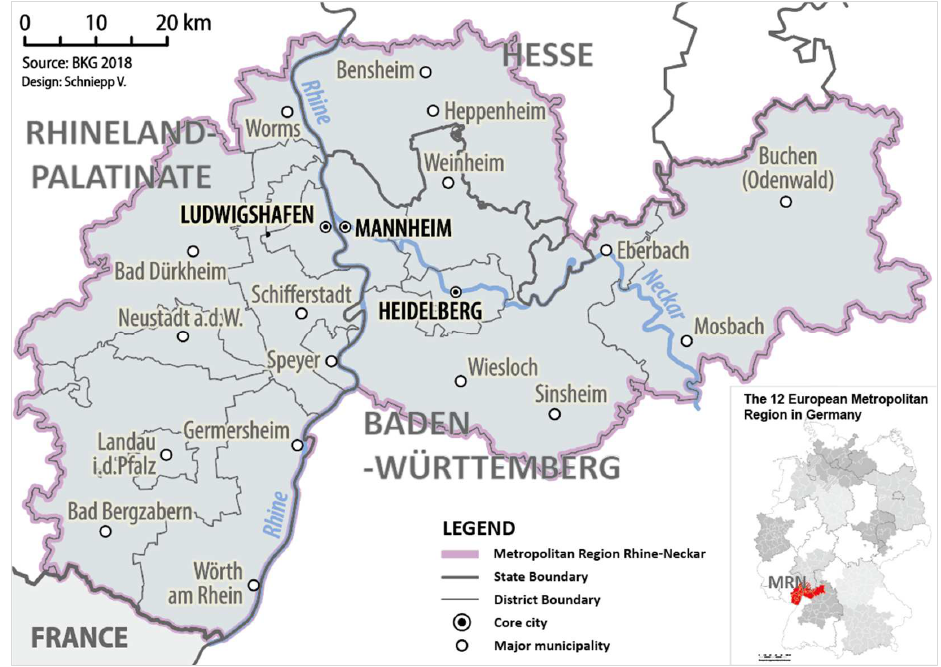
Figure 4. The map of Rhine–Neckar Metropolitan Region. Source: the authors, based on Bundesamt für Kartographie und Geodäsie (BKG) database.